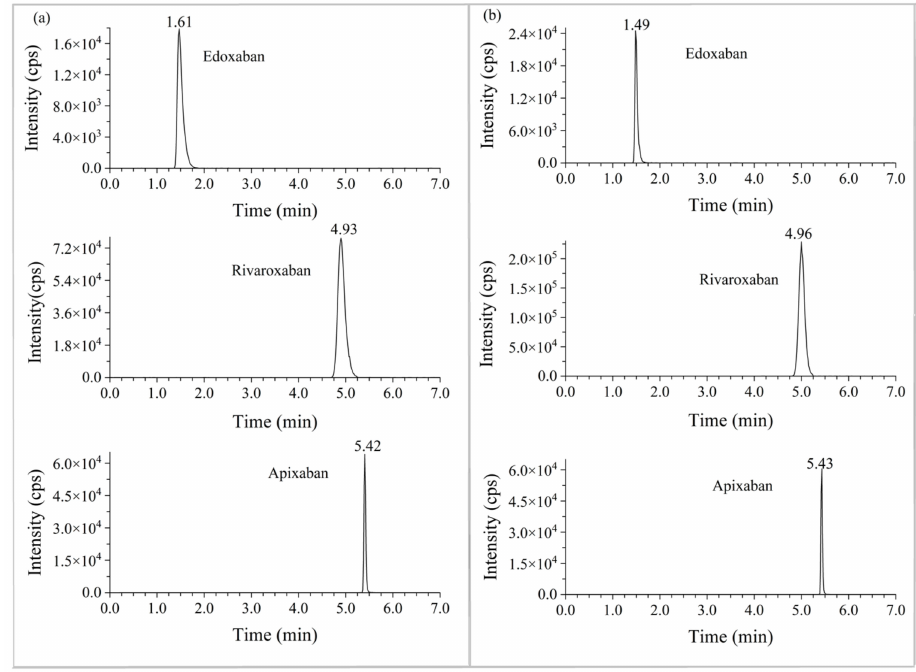
Figure 4. The UPLC/MS/MS chromatograms of the selected DOACs in the plasma ( a ) and urine ( b ) from clinical patients and subjects.